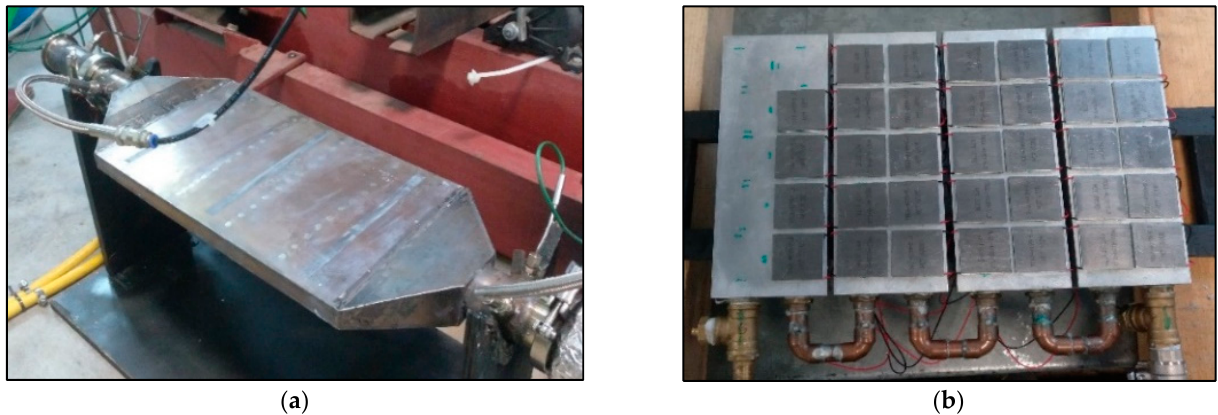
Figure 8. Modified section of the exhaust pipe ( a ) and locations of 40 TEMs on each face ( b ).